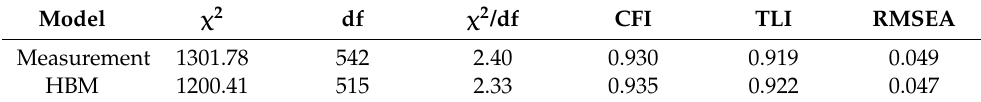
Table 4. Measurement and structural model fit indices. Model χ 2 RMSEA